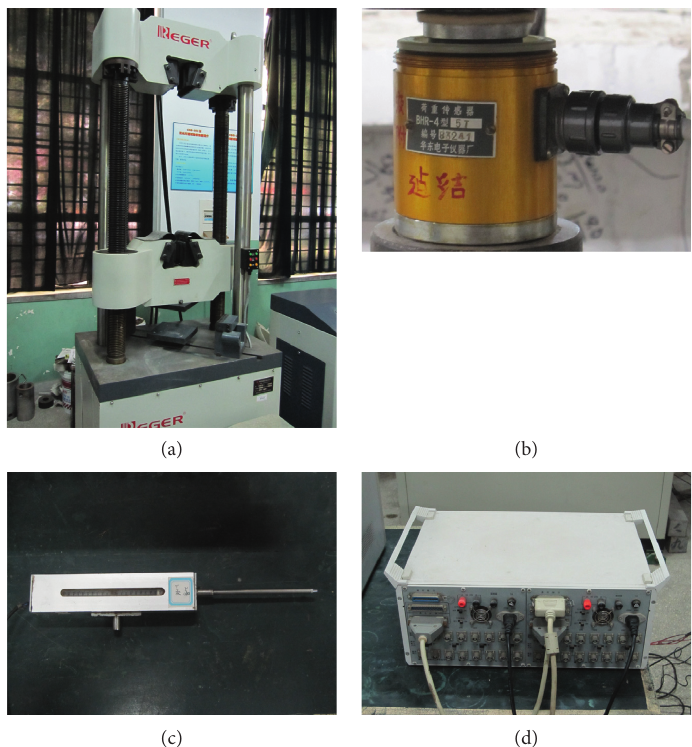
Figure 2: The experimental setup: (a) press machine; (b) pressure sensor; (c) electronic displacement meter; (d) dynamic resistance strain